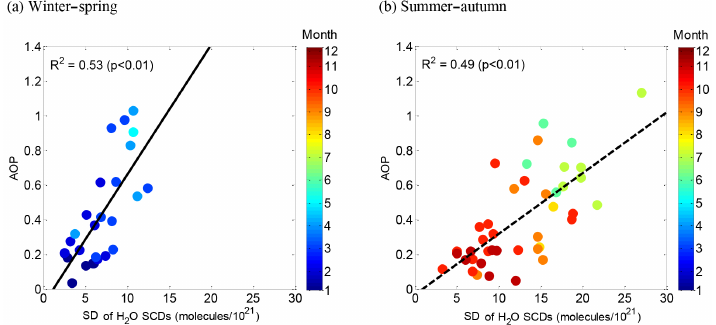
Figure 4. Correlation between daily averaged standard deviation of H 2 O SCDs, a measure of retrieval differences, from 12:00 to 14:00LT, and the corresponding averaged AOP, calculated by scaling AOD data (1020nm) from AERONET based on CLARS geometry, for two time periods in 2013. (a) Winter and spring, including January to May, in which the coefficient of determination ( R 2 ) is 0.53 and [slope, inter- cept] = [0.08 ± 0.03, − 0.09 ± 0.21] with 95% confidence bounds from linear regression. No December data from AERONET are available in 2013. (b) Summer and autumn from June to November, in which R 2 is 0.49 and [slope, intercept] = [0.04 ± 0.01, − 0.03 ± 0.16]. In total, there are 68 days of daily mean data available in 2013, out of which 27 days are for winter–spring and 40 days are for